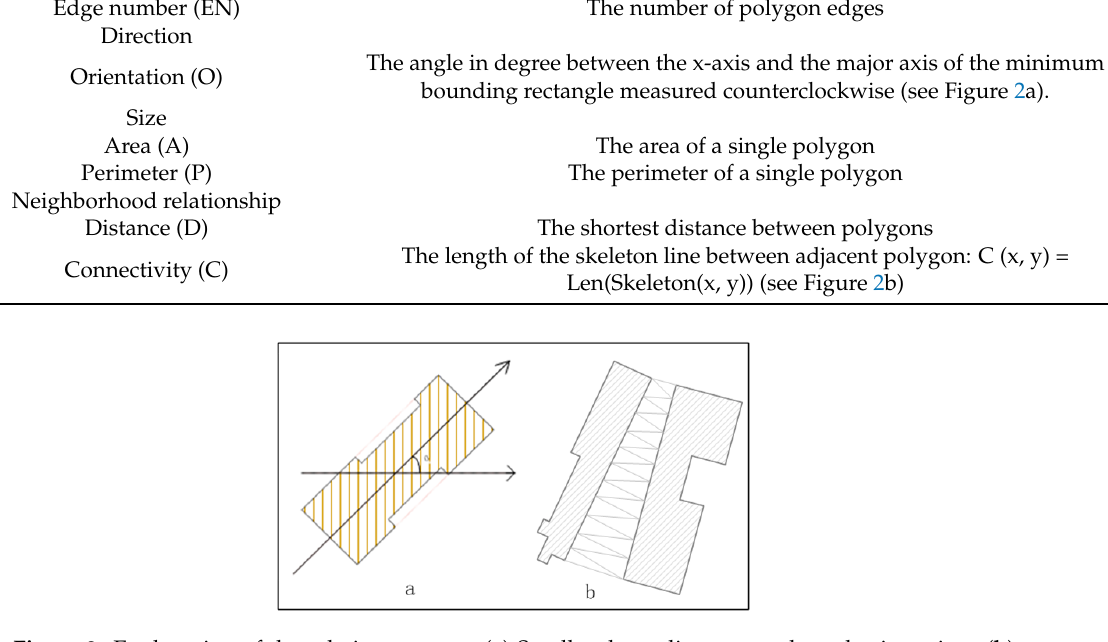
Figure 2. Explanation of the relative concept. ( a ) Smallest bounding rectangle and orientation. ( b ) Skeletons between adjacent polygons.